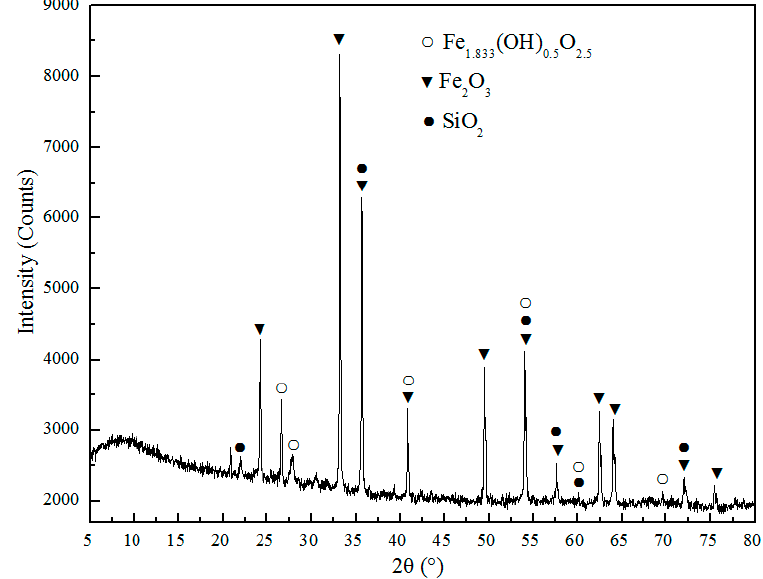
Figure 9. X-ray diffraction pattern of conventional chlorination roasting.